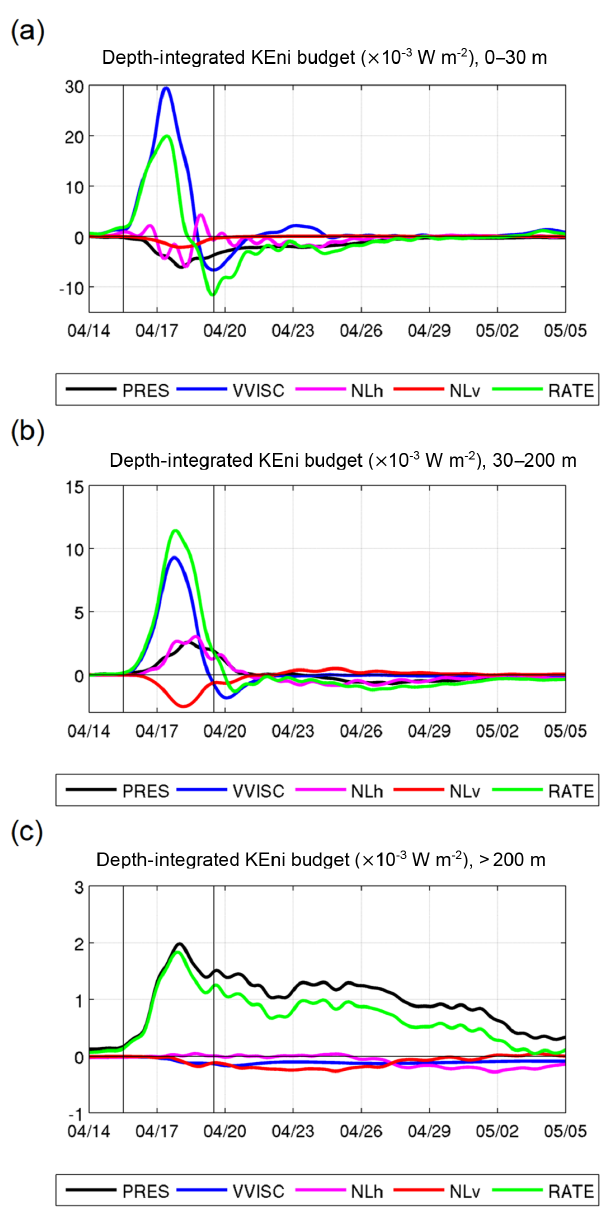
Figure 12. Time series of area-averaged, depth-integrated KEni budget for (a) 0–30m, (b) 30–200m, and (c) > 200m in the forced region. Terms represent (unit: × 10 − 3 Wm − 2 ) pressure work (PRES), vertical viscous effect (VVISC), horizontal non-linear in- teraction (NL h ), vertical non-linear interaction (NL v ), and chang- ing rate of KEni (RATE). The vertical lines separate the pre-storm stage, FS, and RS during the TC forcing.